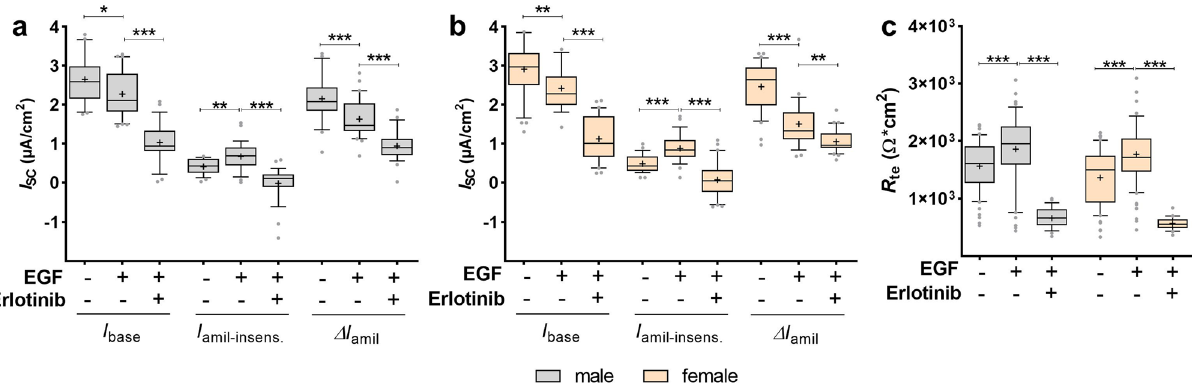
Figure 9. EGFR inhibitor prevented the effect of EGF on I amil-insens and R te , but not on Na + transport. FDLE cells were cultured in SF-Med and stimulated with EGF with or without erlotinib for 24 h. Data are displayed as box and whiskers with the 10–90 percentile, mean (+) and median (horizontal line). EGF significantly decreased I base and Δ I amil in both, male ( a ) and female ( b ) FDLE cells, which was further decreased by erlotinib (n = 26–31; * p < 0.05; ** p < 0.01; *** p < 0.001 by t -test). In contrast, erlotinib prevented the significantly increased I amil-insens induced by EGF in both sexes. ( c ) Erlotinib further prevented the significant increase of R te induced by EGF in both sexes (*** p < 0.001). (Grey boxes) male; (yellow boxes)